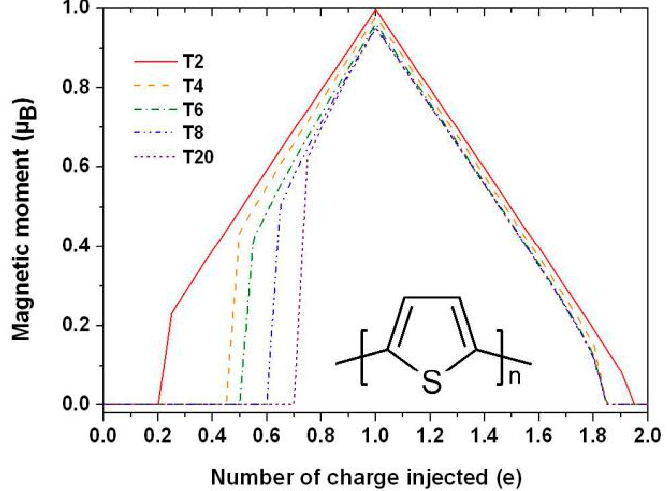
Figure 1. Magnetic moment varies with the quantity of charges injected in different thiophene aggregation degrees. The inset shows the unit structure of the thiophene molecule. By Han et al. [23] with the permission of Organic Electronics.